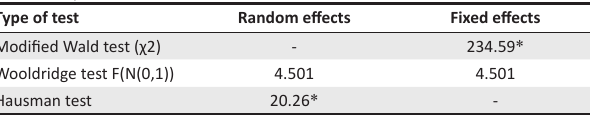
TABLE 2: Specification tests